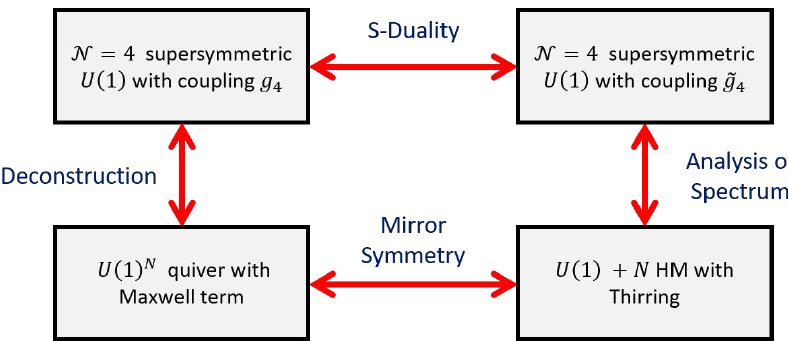
Figure 1: Summary of the relationship between the various supersymmetric theories we con-